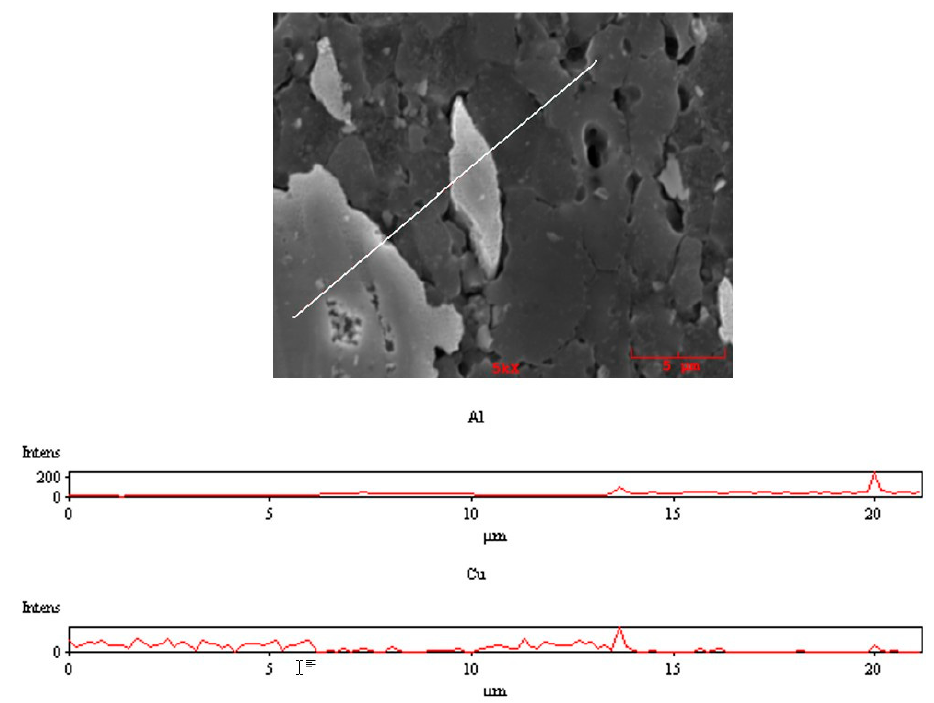
Figure 20. EDS linear analysis (1330/20/1 specimen, zone No. 1).